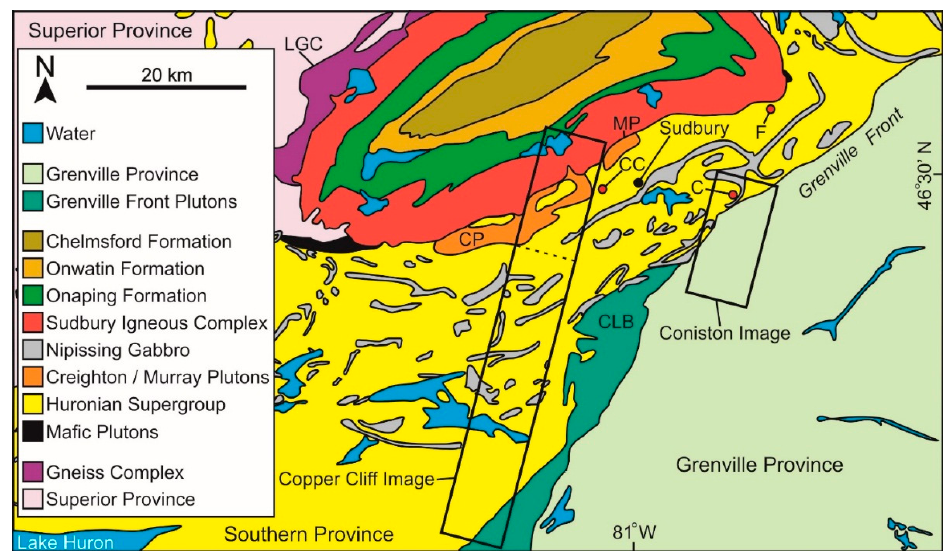
Figure 1. Bedrock geology of the Sudbury region (after [8,10]). Labelled intrusions are as follows: CLB, Chief Lake Batholith; CP, Creighton pluton; MP, Murray pluton; LGC, Levack gneiss complex. The locations of the Copper Cliff (CC), Coniston (C), and Falconbridge (F) smelter stacks are indicated by red circles. The footprints of utilized sections of the Copper Cliff and Coniston Hyperion images are given, and the extents of these footprints define the Copper Cliff and Coniston study areas. The dashed line associated with the Copper Cliff study area separates the main part of the study area (top) from the remainder of the study area (bottom).